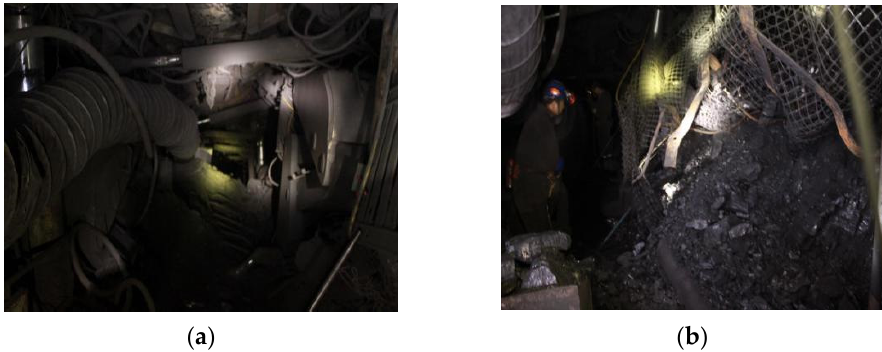
Figure 3. Damage situation at the No. 2 panel area. ( a , b ) support failure at roadway walls.